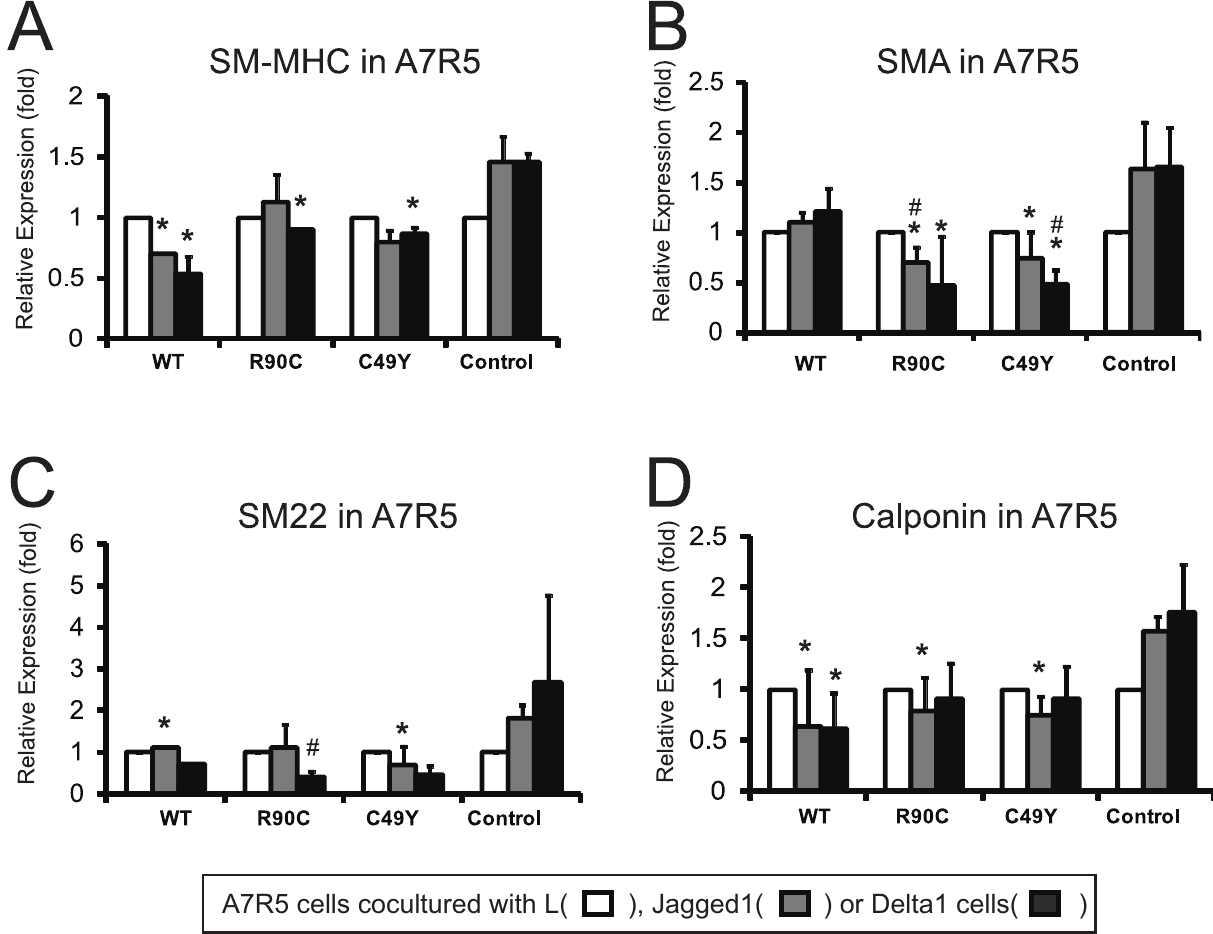
Figure 6. Inhibition of Notch-mediated smooth muscle marker expression by NOTCH3 transfection. A7R5 cells (n=3 replicate wells per group) were cotransfected with NOTCH3 constructs shown. Control was empty vector pCMV-Sport6. After coculture with ligand expressing cells, mRNA levels of genes indicated were measured by quantitative RT-PCR using primers that detect rat sequences present in rat A7R5 cells but not mouse genes. Analysis was performed as noted in the methods and the display show the average level of gene induction in three independent experiments. * indicates differences between NOTCH3 transfected cells versus control cells and # denotes differences between mutant NOTCH3 and wildtype NOTCH3 transfectants (p , 0.05). Error bars represent standard deviations.